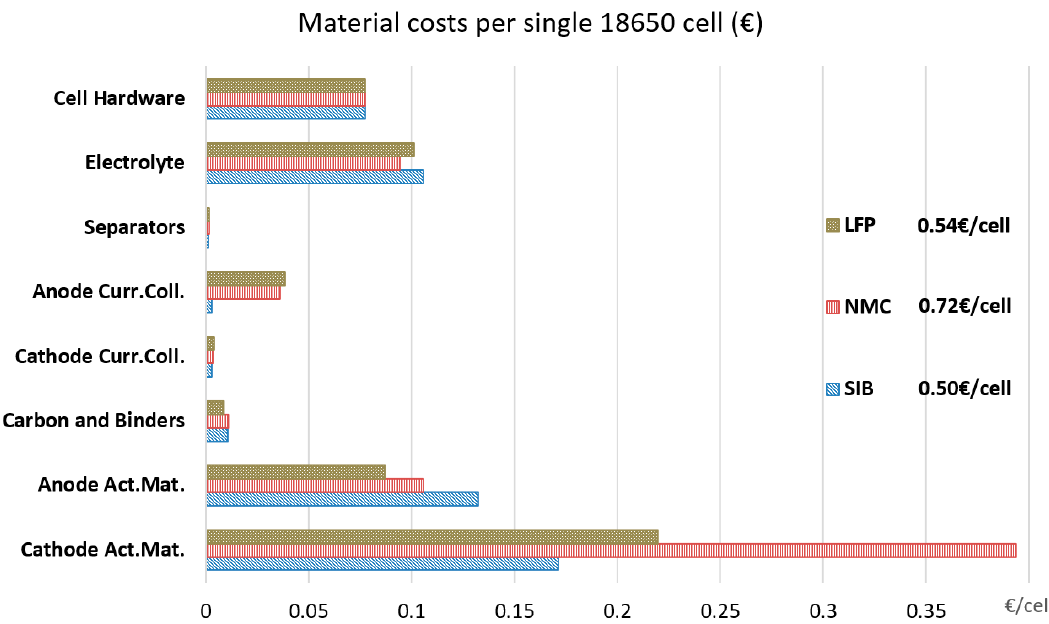
Figure 3. Contribution of battery components to total material costs per single 18650 round cell ( € /cell; disregarding different energy densities/storage capacities of the individual cells).